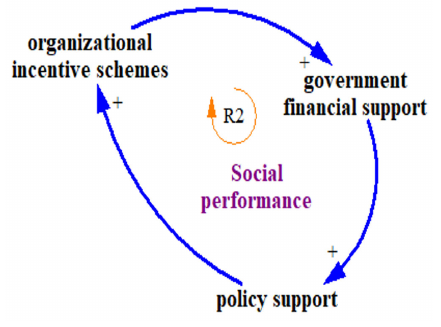
Figure 7. Reinforcing loop R2.